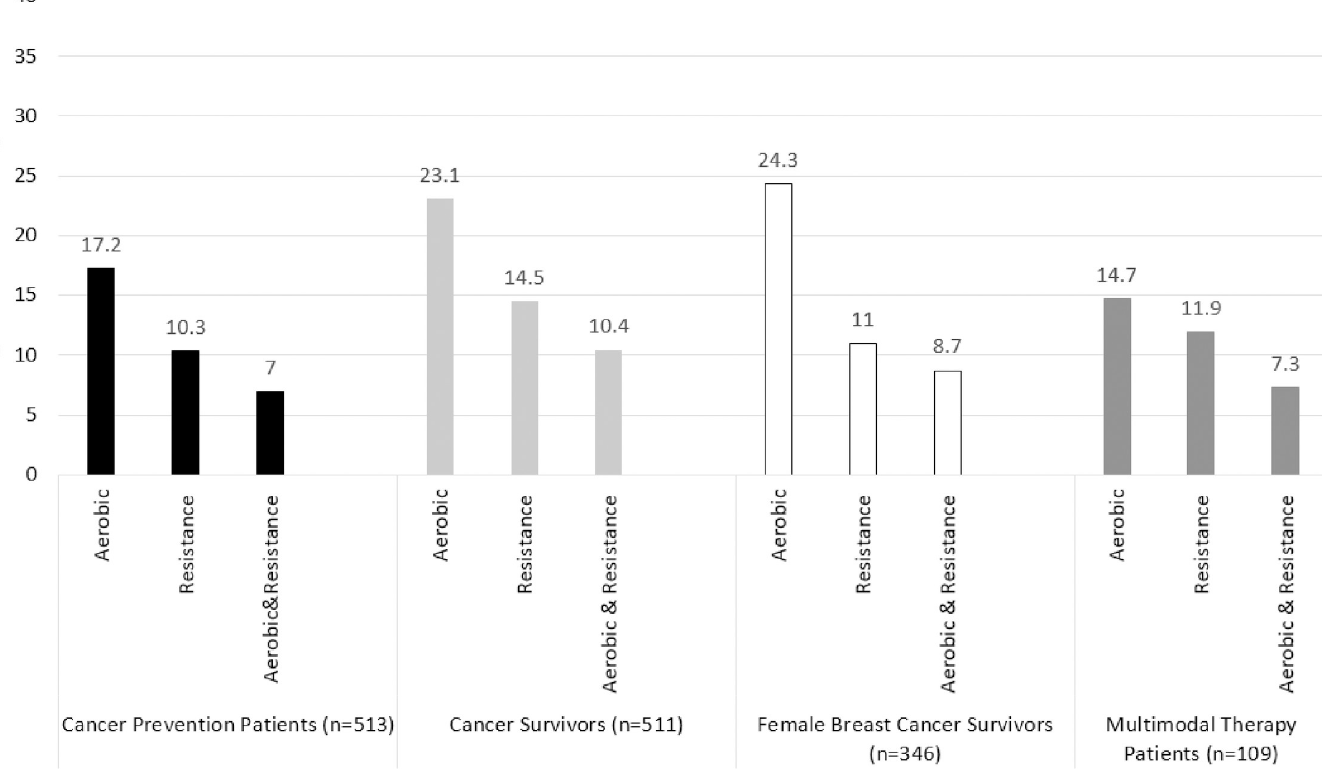
Fig 1. Percentage of patients meeting physical activity